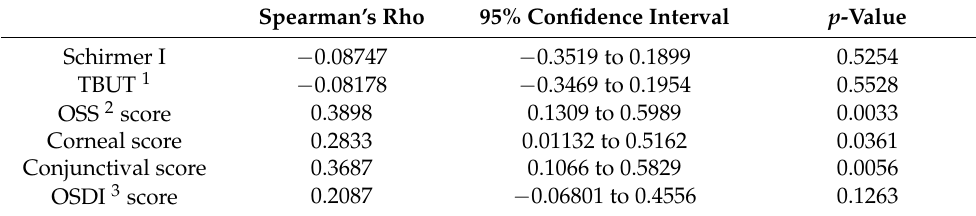
Table 2. Correlation of tear ATG5 with the Schirmer I, tear breakup time, ocular surface staining score, and ocular surface disease index in Sjögren syndrome dry eye disease patients.